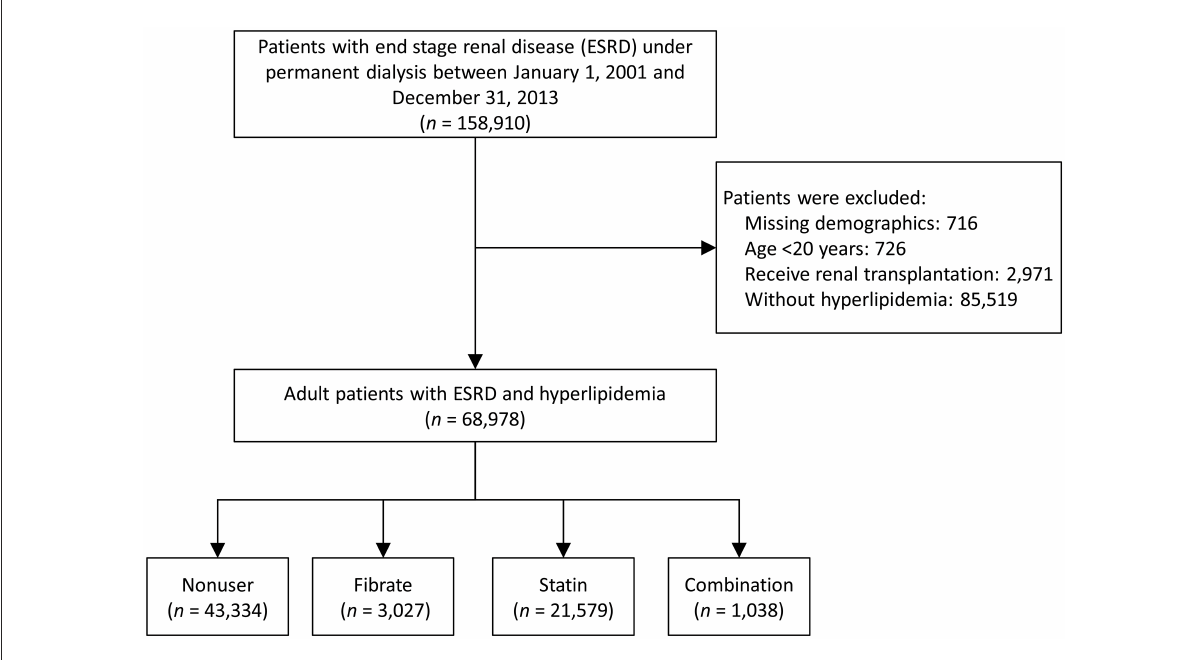
FIGURE1 Flowchart for illustrating the inclusion and exclusion of the